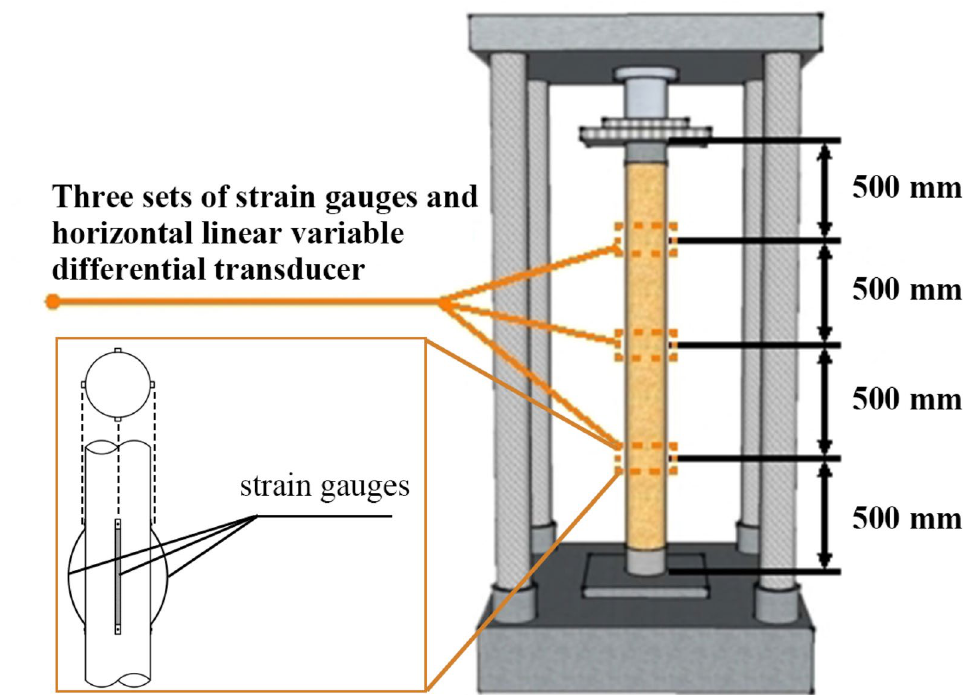
Fig. 10 Test device and layout of